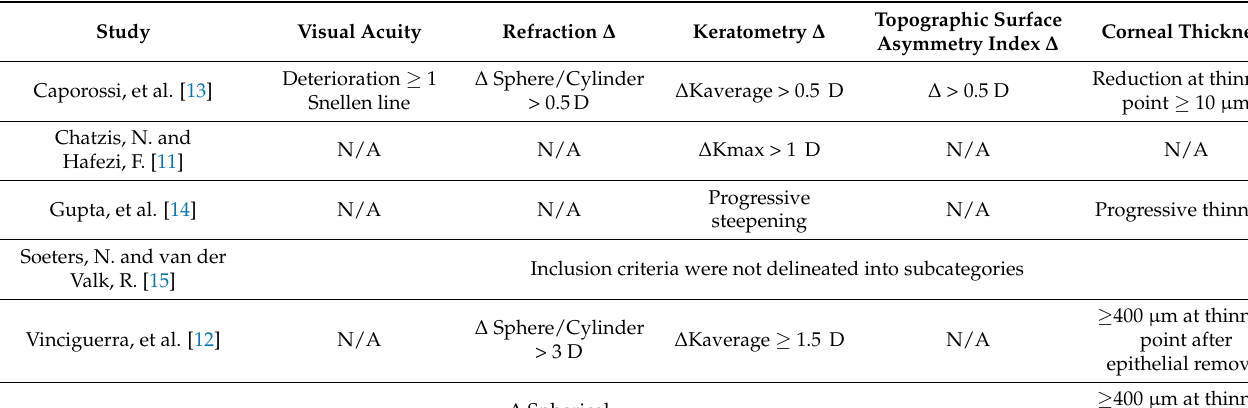
Table 2. The inclusion criteria to determine clinical progression by